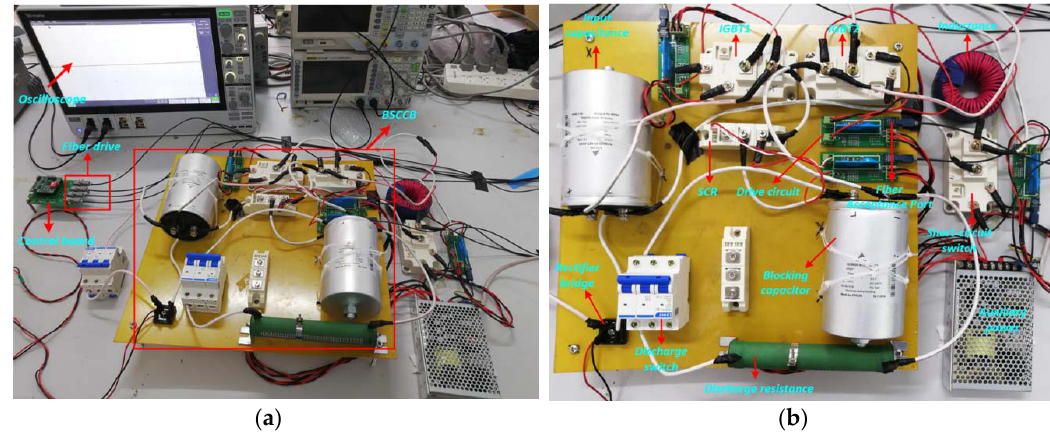
Figure 11. Experimental prototype: ( a ) experimental platform; ( b ) BSCCB.